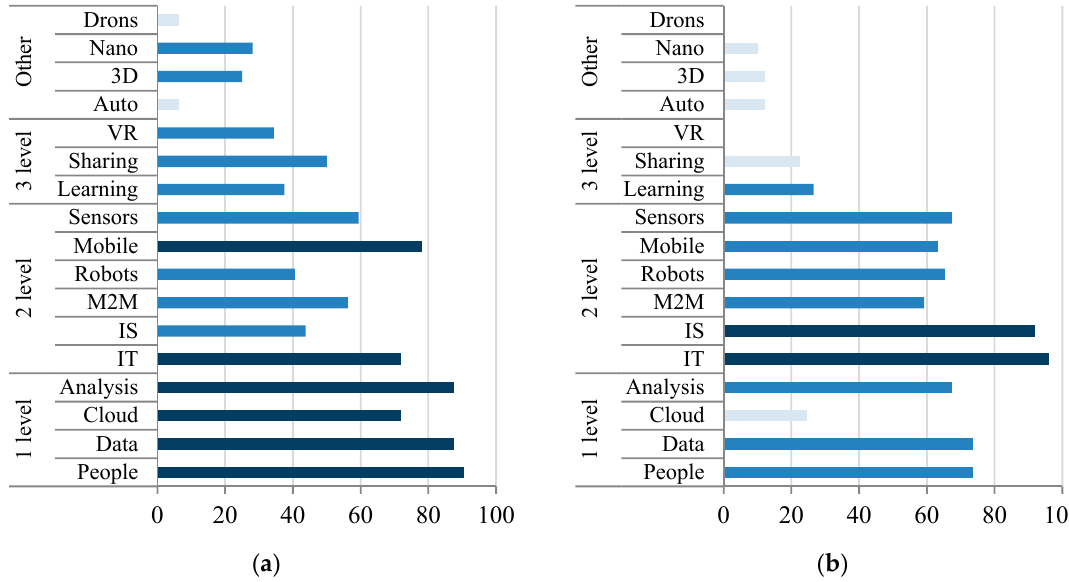
Figure 5. Clusters’ characteristics: ( a ) Cluster 1—I4 technological enterprises; ( b ) Cluster 2—I4 advances enterprises.